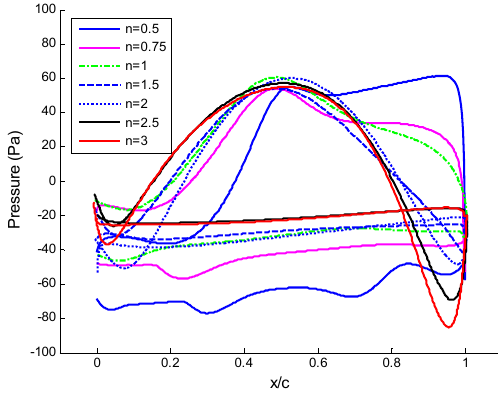
Figure 13. Pressure distributions on the blades for λ = 0.8 and θ = 270°.